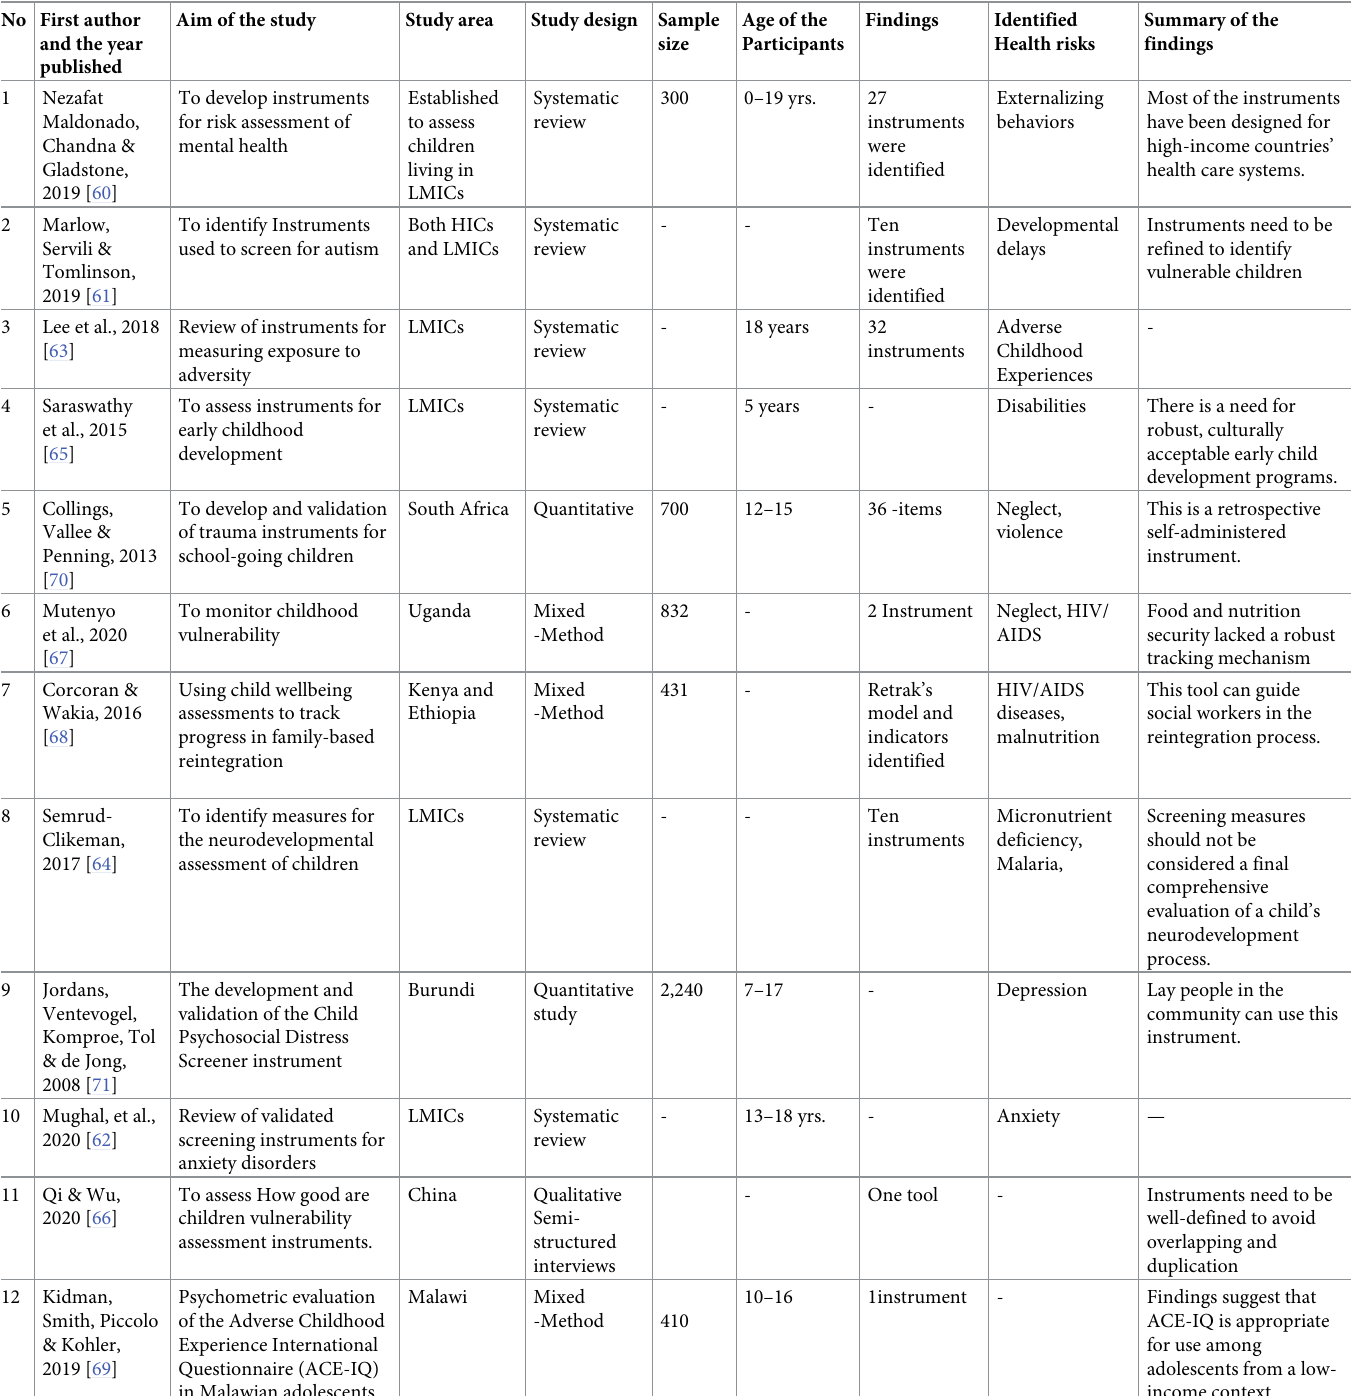
Table 5. Summary of the included studies that identified risk assessment